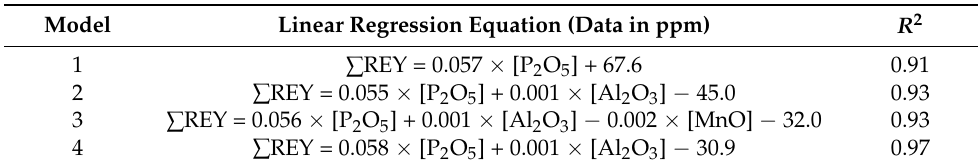
Table 1. Multiples linear regression model between Σ REY and major oxides (data sources as in Figure 1).